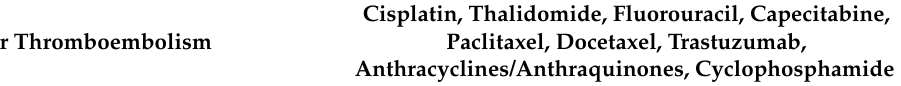
Table 1. Different types of cardiotoxic effects of chemotherapeutic